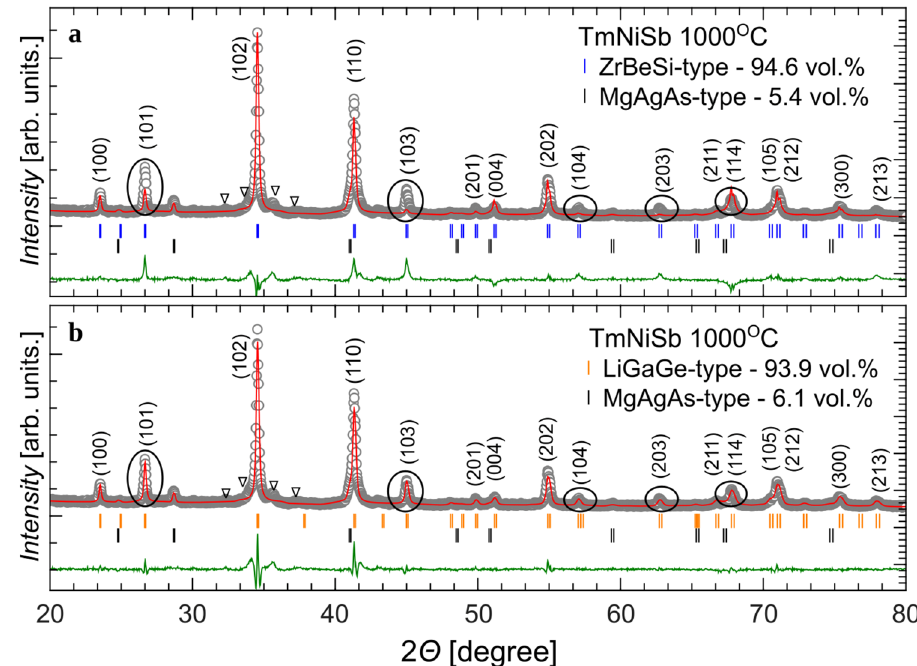
◦ C with Rietveld fit using ZrBeSi-type and